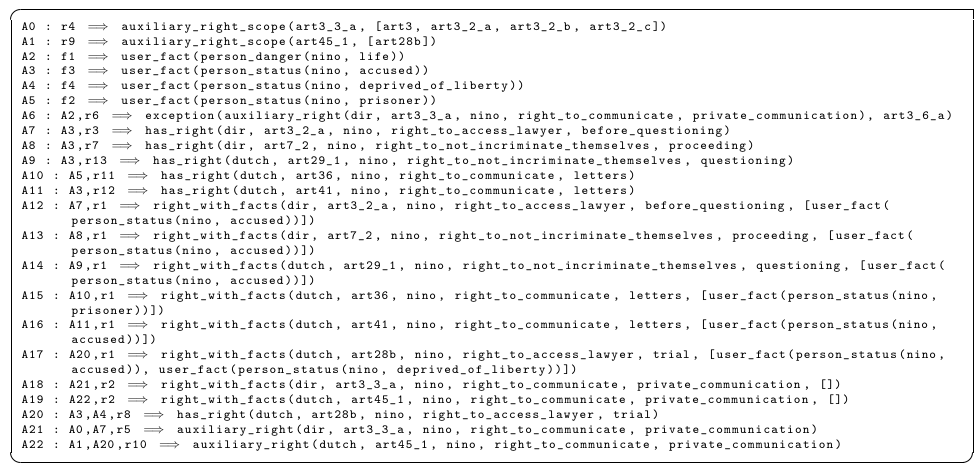
Figure 20. Arguments of the CrossJustice example.